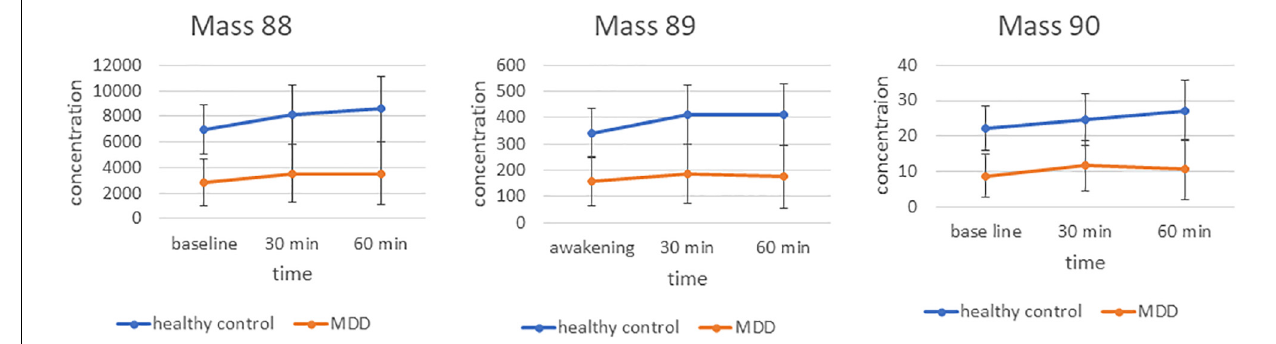
FIGURE 1 | Time course and differences between groups for markers 88, 89, and 90 m/z. Mean concentration in counts per second.